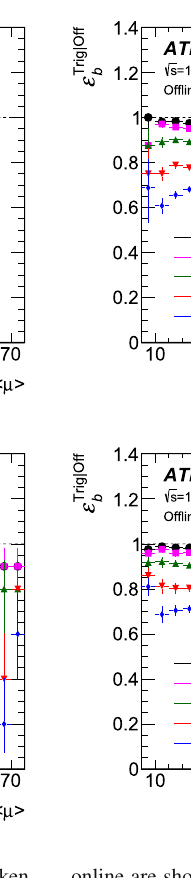
Fig. 15 The conditional b -tagging efficiency, ε Trig in a 2016, b 2017, c 2018, and d simulated t ¯ t events, as a function of pile-up, (cid:5) μ (cid:6) . All working points of the MV2 b -tagging algorithm used